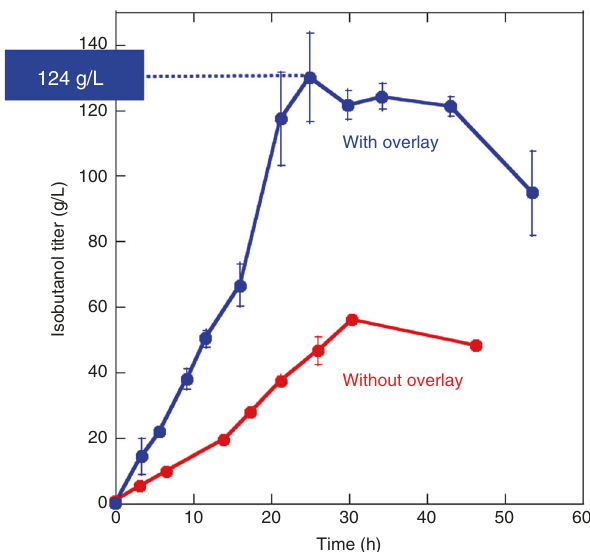
Fig. 4 Reactions in a bioreactor. The graph shows isobutanol titers over time for 15 mL reactions in a bioreactor without (red) or with (blue) an organic overlay. Error bars re fl ect are the standard deviation of technical triplicates. Source data are provided as a Source Data fi